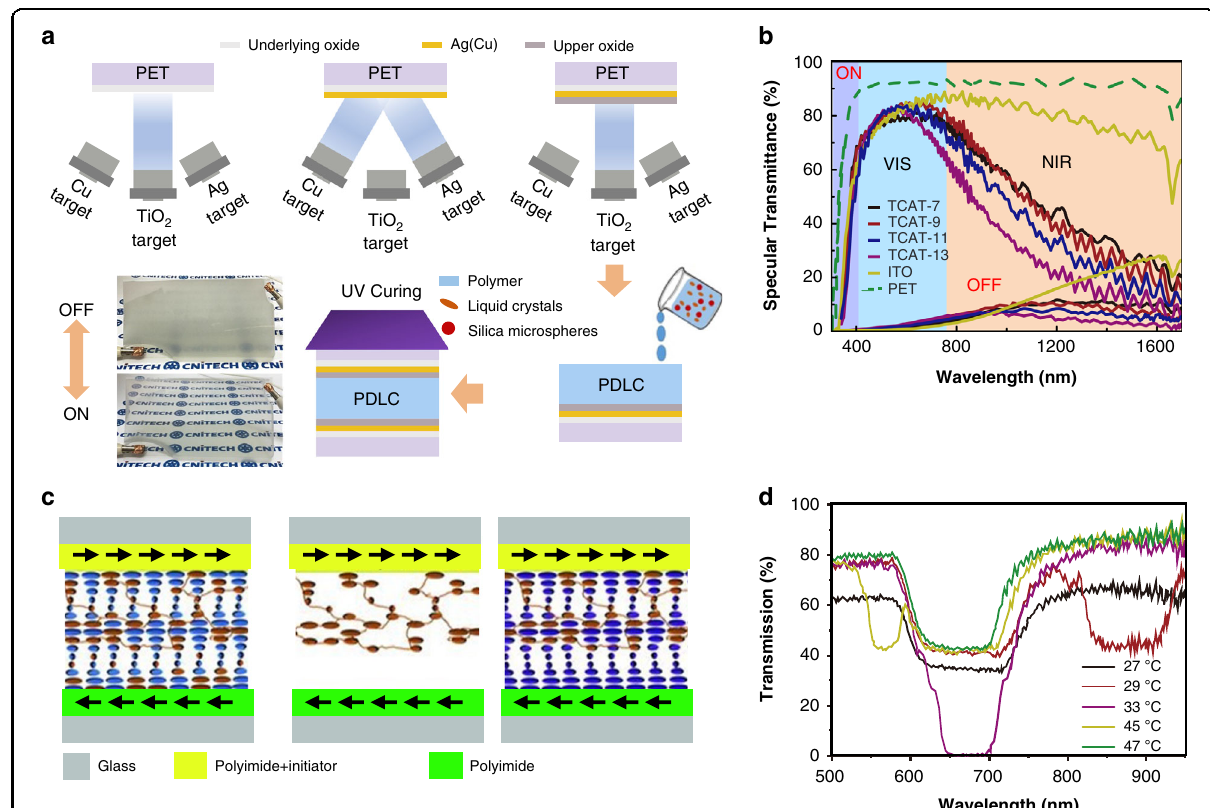
Fig. 19 Switchable optical devices with good temperature management. a TCAT substrate preparation process and sample effect. b Optical properties of PDLC fi lms prepared on different substrates. a, b Reproduced with permission from ref. 230 . Copyright 2019, Elsevier. c Principle of STPN- based composite fi lm fabrication. d The re fl ectance of composite fi lms with different hazes vs. wavelength. c, d Reproduced with permission